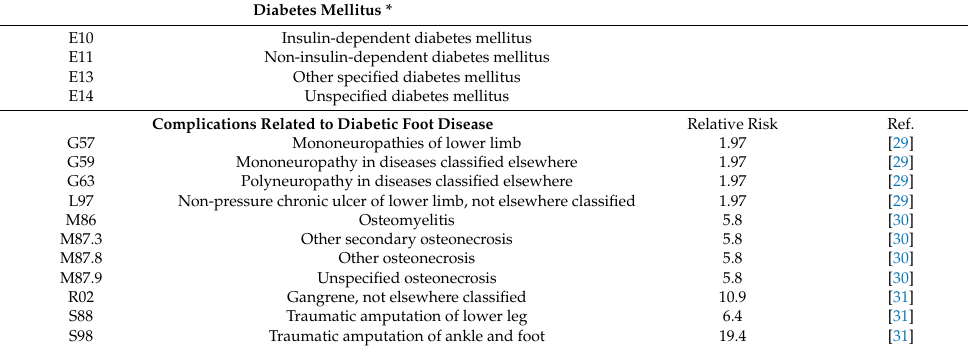
Table 2. Causes of hospitalization and procedures related to diabetic foot disease, as coded by ICD-10 codes, relative risk and